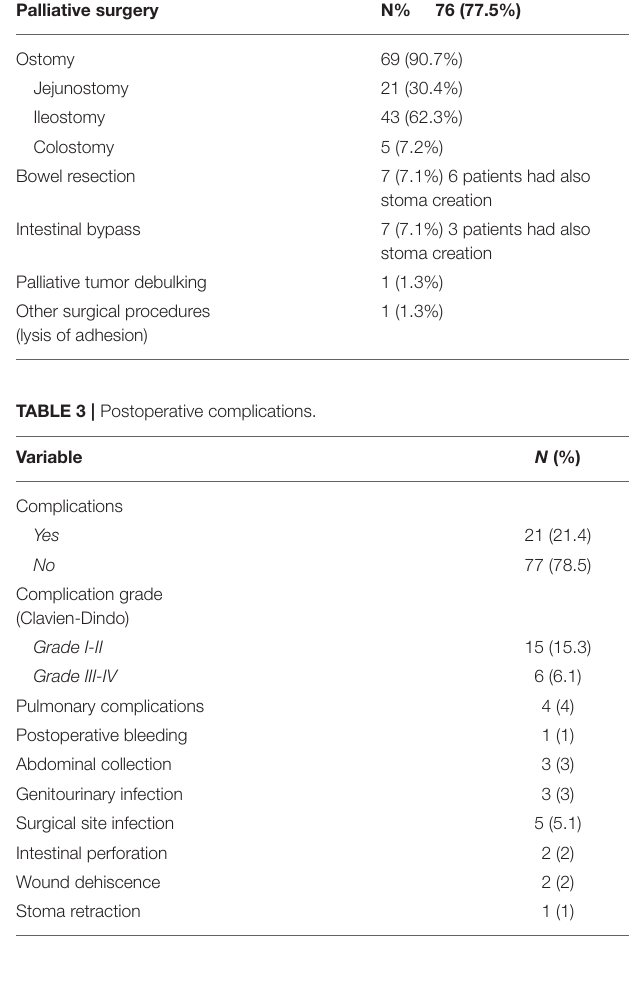
TABLE 4 | Univariate comparison regarding surgery